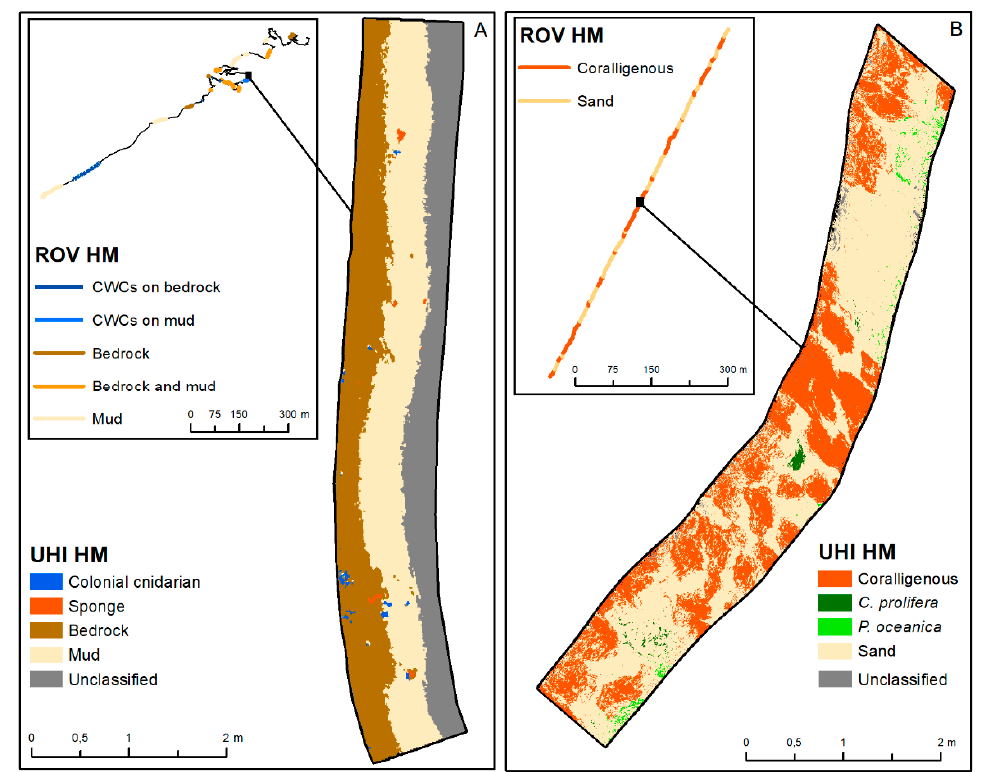
Figure 7. Comparison between the ROV transect classified with conventional methodologies (A and B insert) and the UHI classification for ( A ) CWC and ( B ) coralligenous sites. The image shows the higher level of detailed obtained by the UHI camera, in contrast with the larger amount of data analyzed by the ROV video.